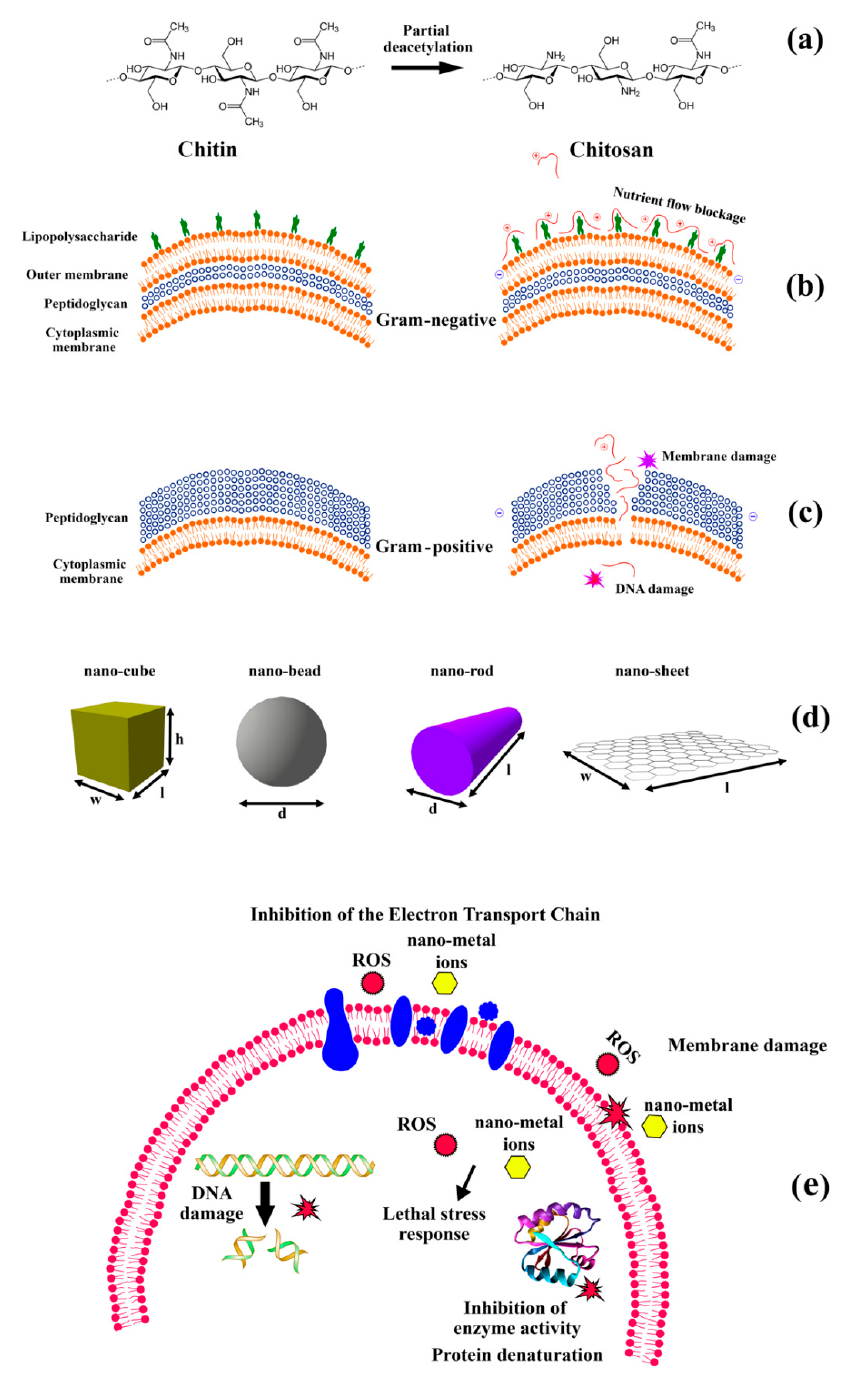
Figure 1. ( a ) Chitosan production by partial deacetylation of chitin, ( b , c ) schematic of the Gram- negative and -positive bacteria cell membranes and proposed models for the action of chitosan on cell membrane nutrient flow blockage and damage. The polycationic nature of chitosan causes the release of intercellular components, binding to bacterial DNA (inhibition of mRNA), blocking the nutrient flow and chelation of essential metals (redrawn from Kravanja, Primožiˇc, Knez, and Leitgeb, 2019) [64], ( d ) schematic of different shapes of metal nanomaterials (reproduced from Cheeseman et al., 2020) [53] and ( e ) a summary of potential passive antimicrobial mechanisms of metal nanomaterials (not to scale) including physical interactions, release of ions, and production of ROS (adapted from Cheeseman et al., 2020)